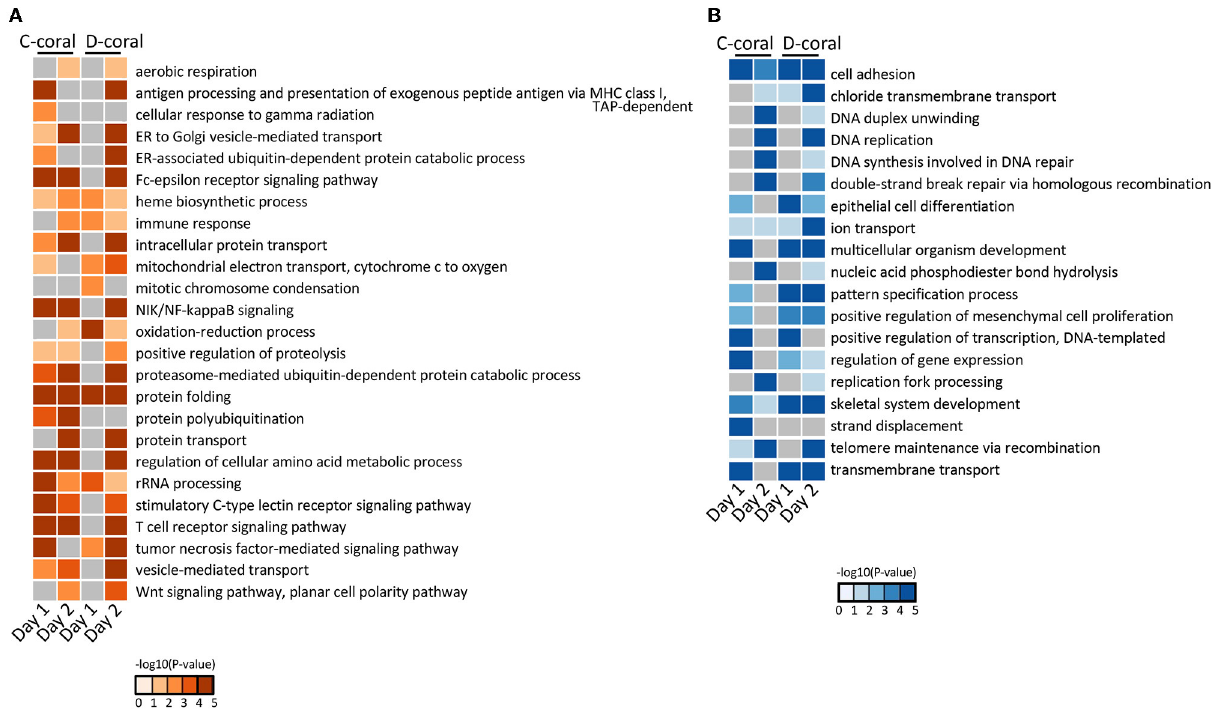
Frontiers in Physiology |